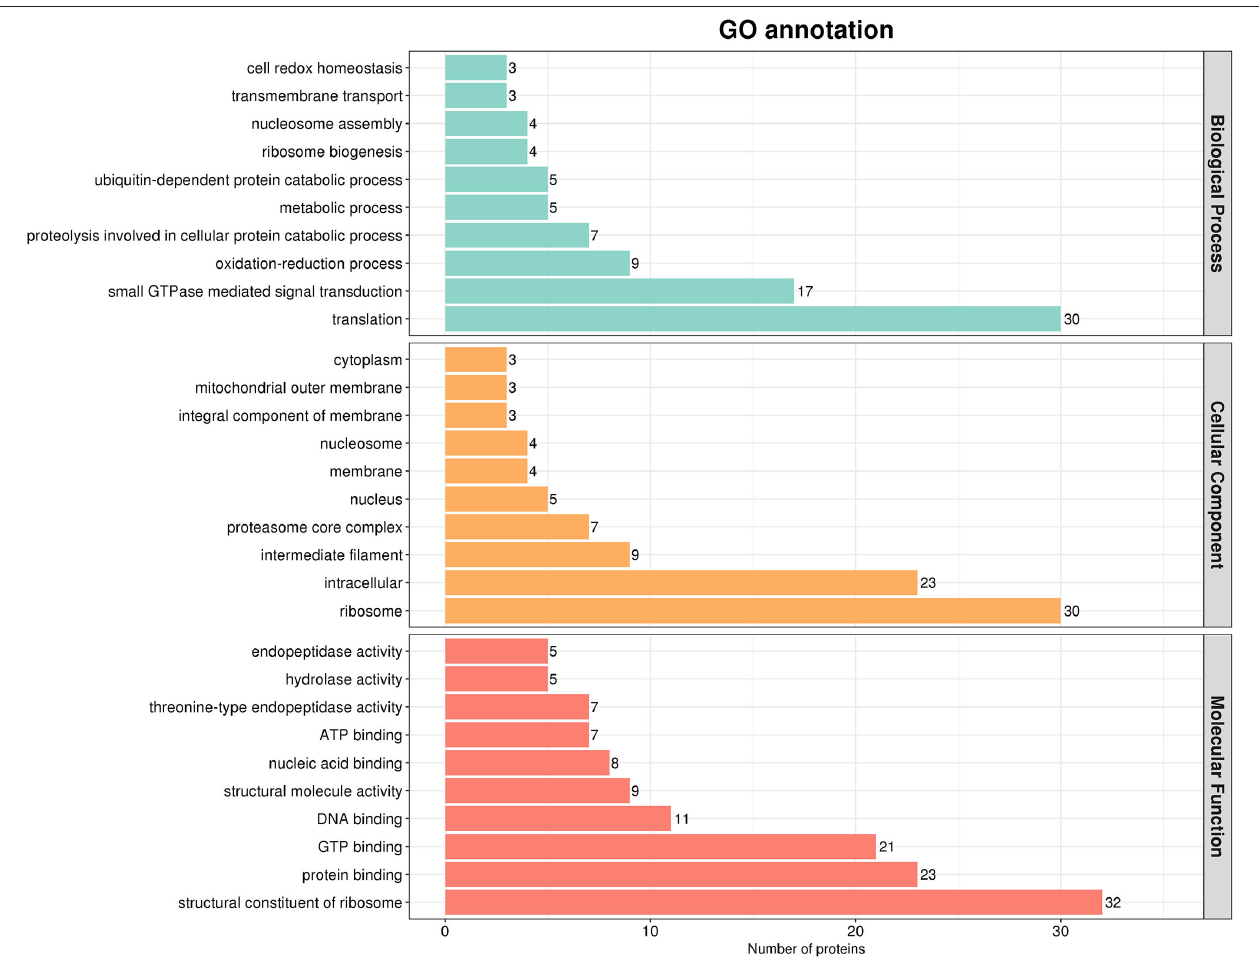
FIGURE 3 | Gene ontology (GO) analysis based on the interaction between cell protein and M. Using Cytoscape v.3.8.2 and ClueGO software plug-in, the GO distributions of all proteins were divided into three types. The y was shown for significantly enriched terms based on biological process, molecular function (MF), and cellular component at p <